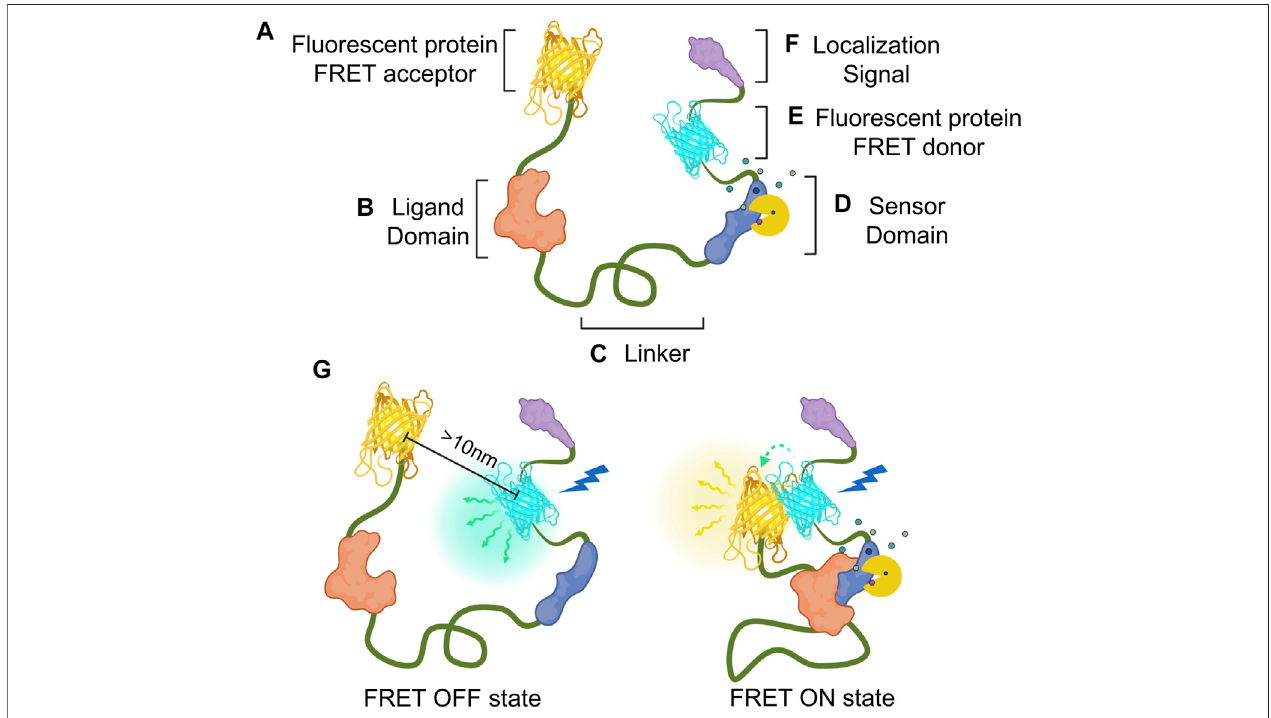
FIGURE 1 | Composition and mechanism of FRET-based GEB. Genetically encoded biosensor (GEB) consists of the following components. (A,E) Fluorescent proteins for acting as acceptor and donor, respectively; (B) ligand domain for recognizing the conformational change of the sensor domain; (C) linker for connecting the componentsoftheGEB,whichcanaffectthestructureandperformanceofGEB; (D) sensordomainfordetectingresearcher ’ stargetofinterestsuchasenzymeactivity (yellow Pacman shape) or target molecule (small polygons); and (F) localization signal for placing GEBs in speci fi c microdomains in a cell. (G) Mechanism of FRET- based GEB on FRET OFF state and FRET ON state. In the FRET OFF state, because ligand and sensor domain are not interacting with each other, donor and acceptor fl uorescent protein generally keep a distance longer than 10 nm. Therefore, donor emission (green winding arrow and blue-green emanating glow) can be mainly detectedbydonorexcitation(bluethundershape).ButIntheFRETONstate,sinceGEBisactivatedbyaspeci fi ctargetsignal,Theinteractionbetweenligandandsensor domain makes two fl uorescent proteins close. Due to this FRET phenomenon (green dashed-fading arrow), acceptor emission (yellow winding arrow and yellow emanating glow) can be mainly detected by donor